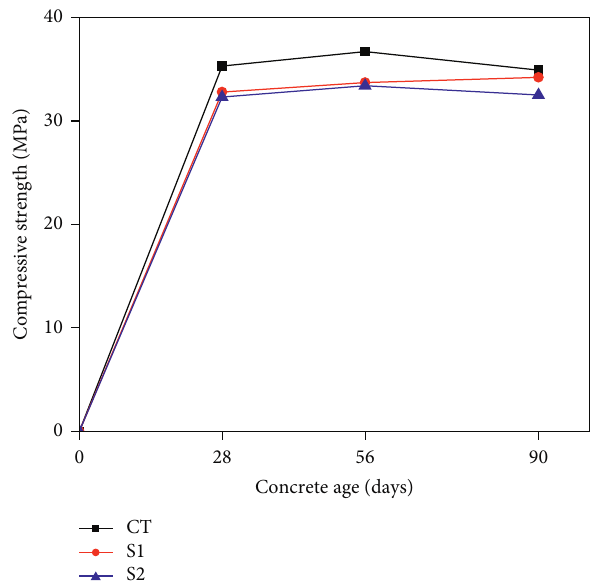
Figure 7: Compressive strength of concrete CT, S1, and S2 immersed in the chloride Table 7: Physical characteristics of concrete mixes after exposure to the chloride solution: without significant surface damage. Sample